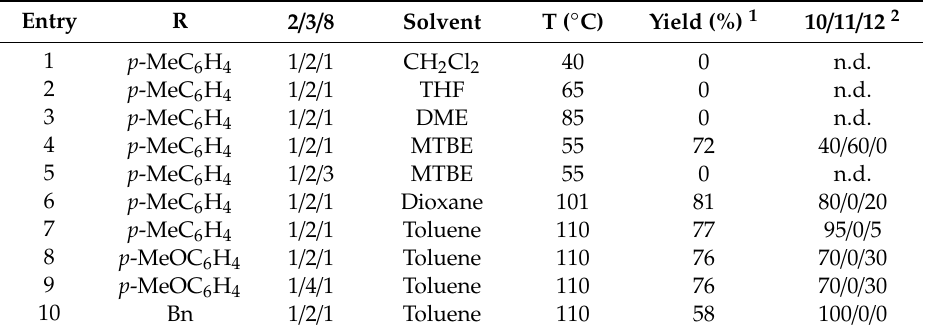
Table 1. Three-component reaction of ethyl pyruvate 1 , benzaldehyde 2 , and amines 3 .